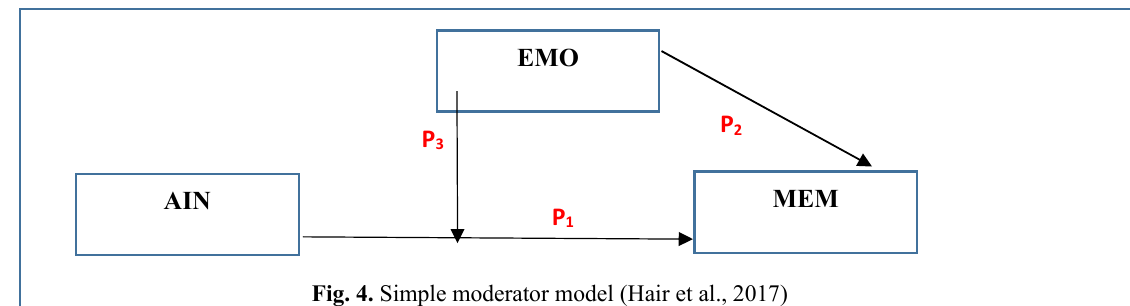
Fig. 4. Simple moderator model (Hair et al.,